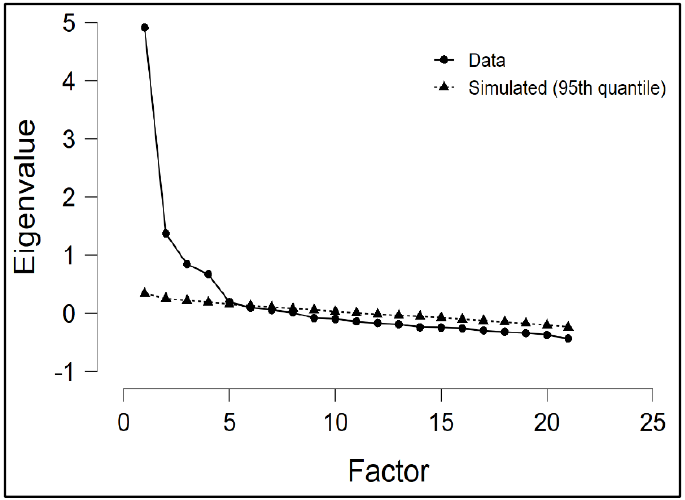
Figure 1. Scree plot with parallel analysis demonstrating the dimensionality of four factors. Note, the first EFA run also showed that four items (SD22, SD23, A2, A19) did not conform to the initially proposed structure demonstrating multiple or low factor loadings (<0.40). These were excluded from the factor model. Table 1 shows the four-dimensional structure, the factor loadings, and the uniqueness of the items, i.e., the variance that is not shared with other variables (the unique